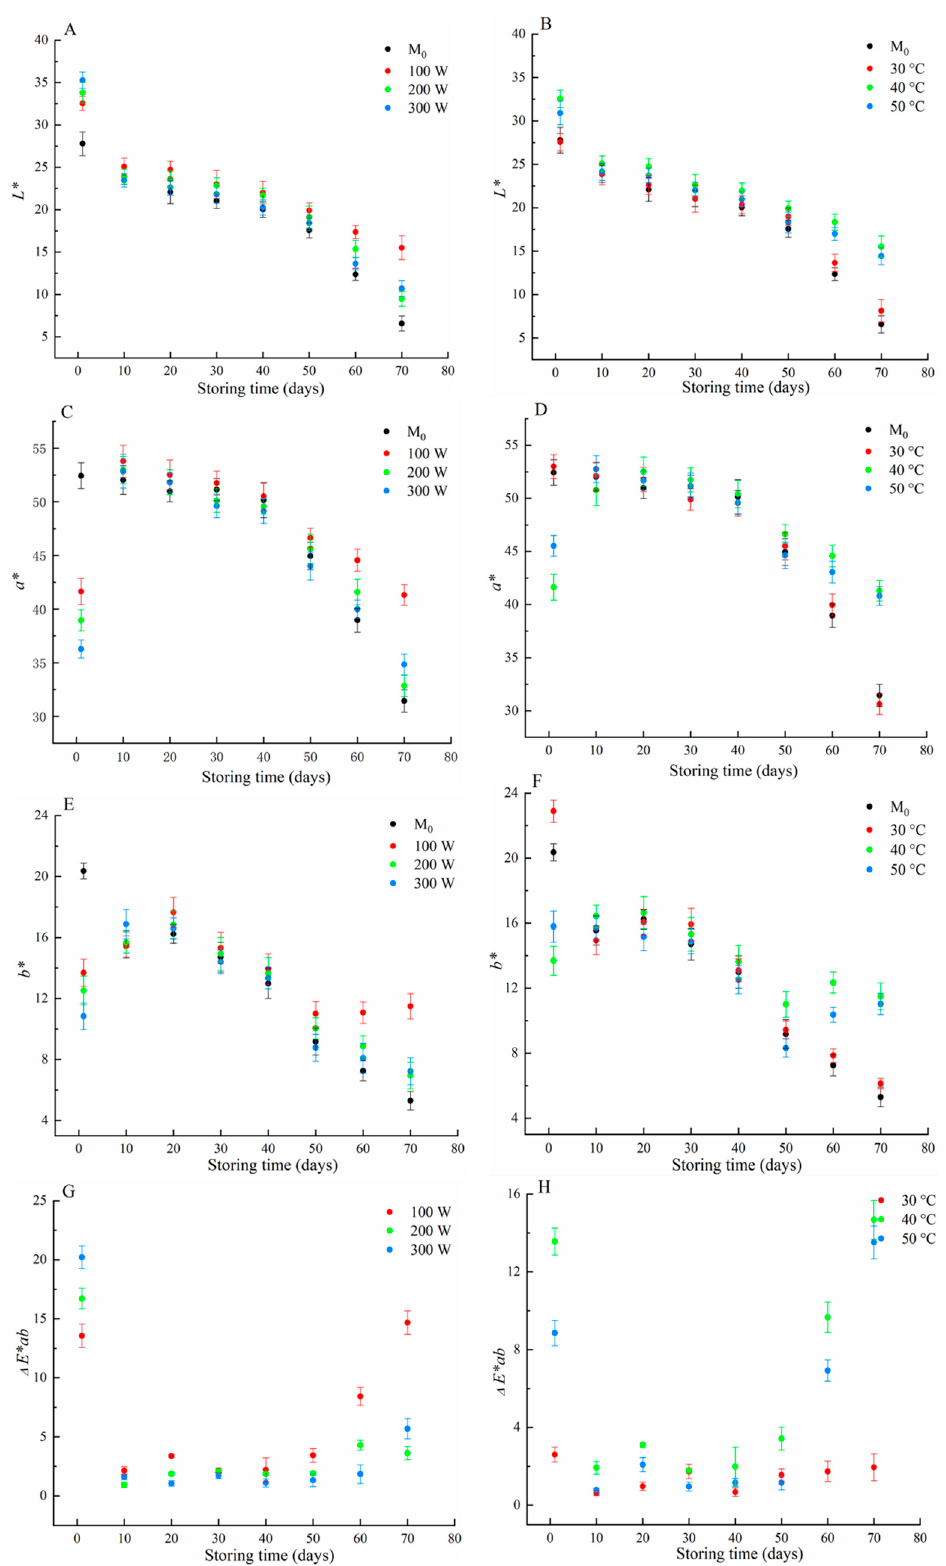
Figure 1. Effect of microwave power and temperature on L *, a *, b *, and Δ E * ab of red wine during storage. ( A ) L * value at different microwave power; ( B ) L * value at different microwave temperature; ( C ) a * value at different microwave power; ( D ) a * value at different microwave temperature; ( E ) b * value at different microwave power; ( F ) b * value at different microwave temperature; ( G ) ∆ E * ab value at different microwave power; ( H ) ∆ E * ab value at different microwave